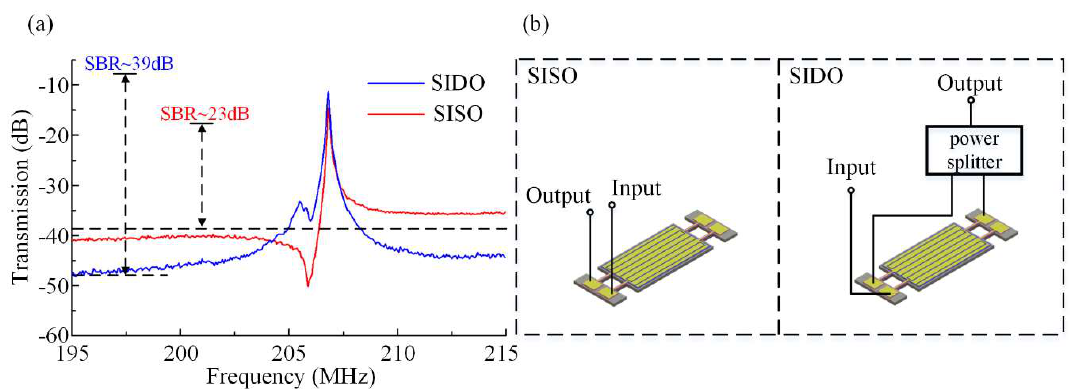
Figure 11. Measured electric transmission for a resonator operating in SIDO (blue trace) and SISO (red trace) setups. (a) The red trace is the result for SISO, and the response of the SIDO setup is shown as the blue trace. Measurement result for SIDO is better than that for SISO in both insertion loss and feedthrough suppression. (b) Measurement configurations of resonator operating in SISO and SIDO respectively.